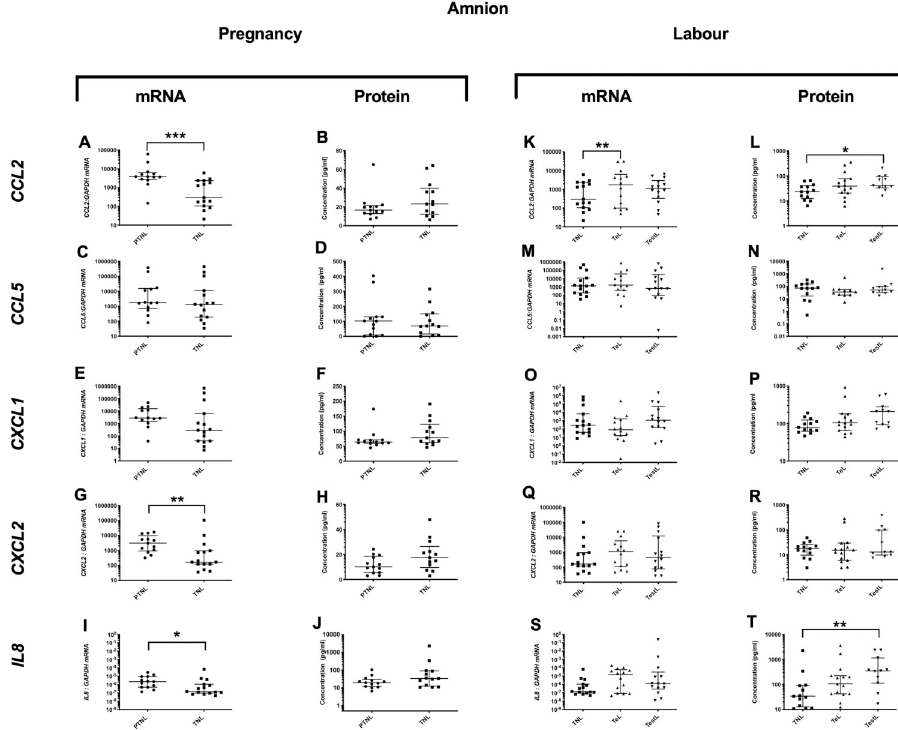
Fig 3. Chemotactic cytokine changes in the amnion. Amnion tissue levels of cytokines from four groups of women (mean gestational age ± SD in each case), PTNL (33.8 ± 1.7 weeks, n = 12), TNL (39.3 ± 0.9 weeks, n = 13), TeL (cervical dilatation < 3cm, 38.6 ± 1.2 weeks, n = 15) and TestL (cervical dilatation > 3cm, 39.6 ± 1.2, n = 11) were compared. Tissue levels of the cytokines were quantified using Bio-plex human cytokine 19-plex-array kit (Bio-rad) and a separate assay for CCL5 as describe in Materials and Methods . A subset of amnion samples, PTNL (33.3 ± 1.9 weeks, n = 13), TNL (39.0 ± 1.0 weeks, n = 15), TeL 38.5 ± 1.3 weeks, n = 14) and TestL (39.4 ± 1.1, n = 14) were used to compare the mRNA expression using rtPCR CCL2 , CCL5 , CXCL1 and CXCL2 , IL-8 . Normally distributed data were analysed using a Student’s t-test for two groups and an ANOVA followed by a Dunnett’s or Bonferroni’s post-hoc test for three groups or more. Data that were not normally distributed were analysed using a Mann Whitney test for 2 groups and when comparing three groups or more a Friedman’s test, with a Dunn’s multiple comparisons post-hoc test. The data are shown as median with interquartile range. The p values are demonstrated by � is p < 0.05 and �� is p <